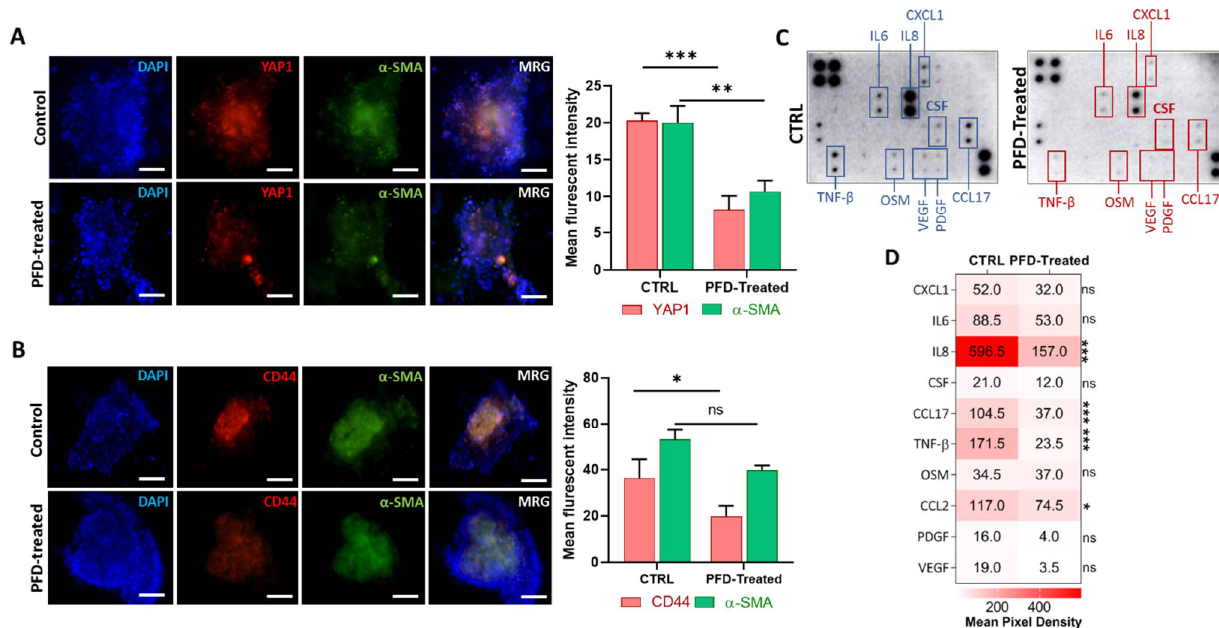
Figure 5. PFD reduces CAFs activity and expression of CD44 and YAP1 through the blockade of key cytokine secretion. ( A ) The immunofluorescence staining shows a significant decrease in protein expression of YAP1 and α -SMA following treatment with PFD (scale bar: 100 µ m). ( B ) Besides α -SMA, PFD also reduced the expression of CD44 in spheroids that include CAFs (scale bar: 100 µm). ( C ) The picture of cytokine profiling performed on culture medium retrieved from PFD-treated and non-treated spheroids in devices. The array shows the depletion of numerous cytokines in treated samples. ( D ) The quantitative analysis of the mean-pixel density analysis of cytokine membranes using ImageJ software, shows a significant depletion of IL6, IL8, CCL17, TNF-β. * p < 0.05, ** p < 0.002, *** p < 0.0002, using Student t -test ( A , B ) and ANOVA ( D ) .